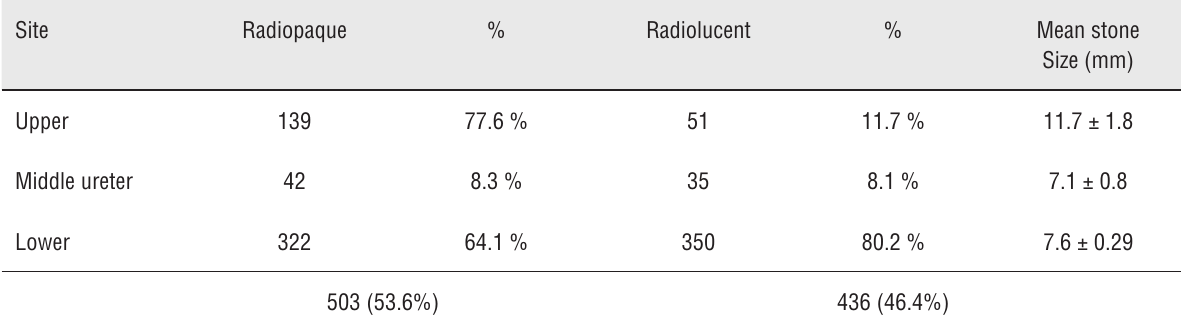
Table 2 - Site and size of ureteral stones by KUB in 939 cases. Site Radiopaque %